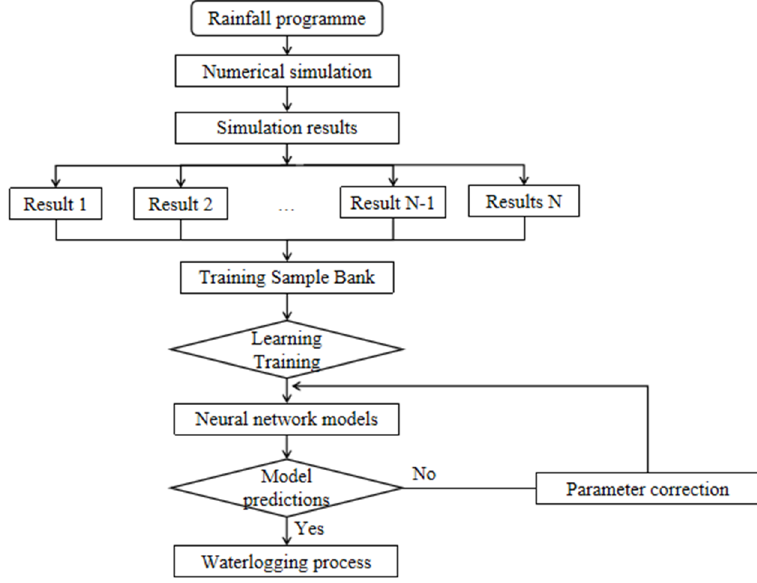
Figure 2. Technical flow chart.